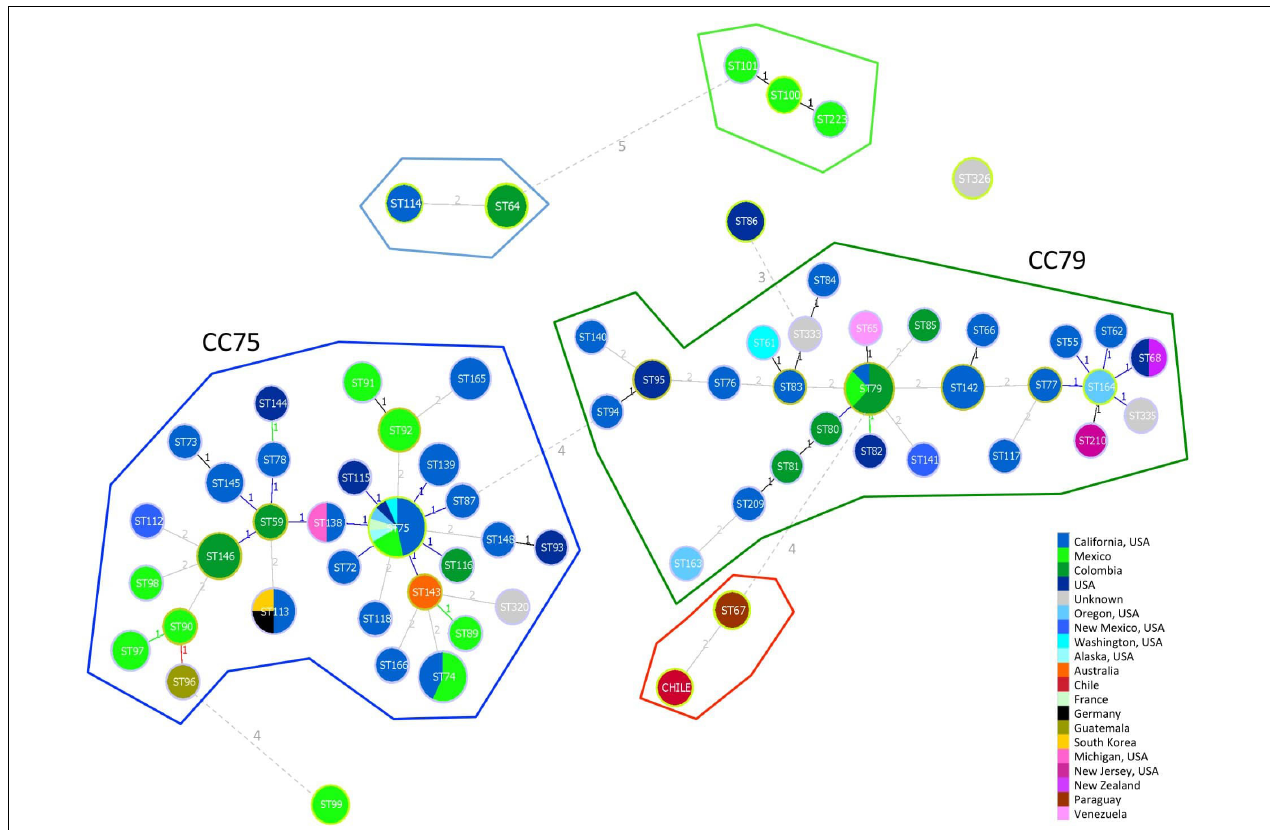
FIGURE 2 | Minimum spanning tree reporting the main clonal clusters among C. bacillisporus VGIII sequence types. Circle sizes are proportional to the number of strains with the same sequence type. Different colors represent different geographic origins. Numbers beside the lines linking two circles indicate the number of different alleles. Yellow circles surrounding STs identify the founder of a clonal cluster. Clonal clusters, including STs differing in one or two alleles, are grouped inside closed lines with different